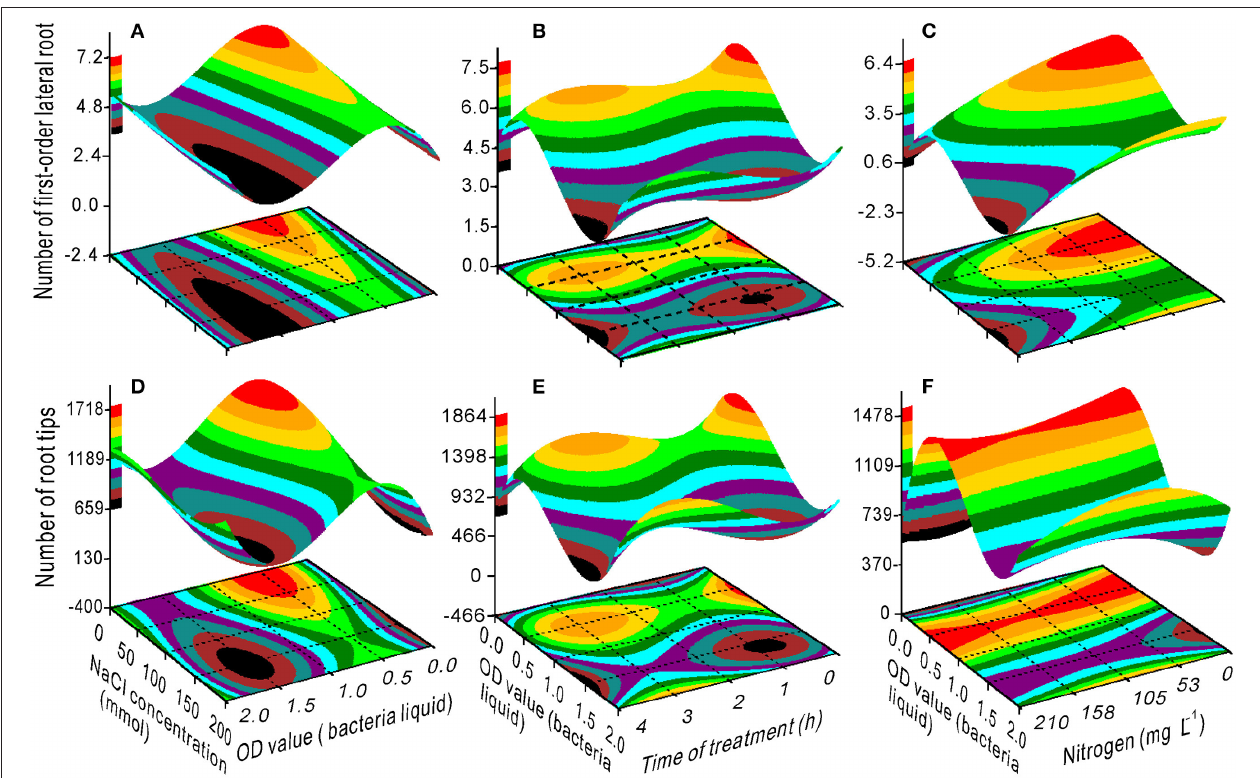
FIGURE 3 | Response surface plots showing the interactions between NaCl and bacterial liquid, bacterial liquid and treatment time, and bacterial liquid and nitrogen on the number of secondary (A–C) and tertiary roots (D–F) .